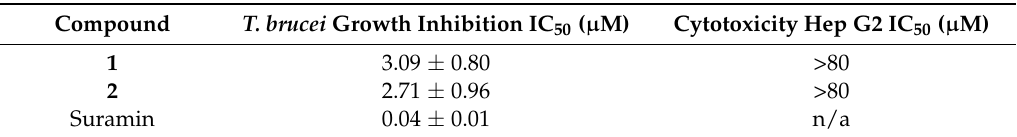
Table 2. Bioassay data of compounds 1 and 2 .